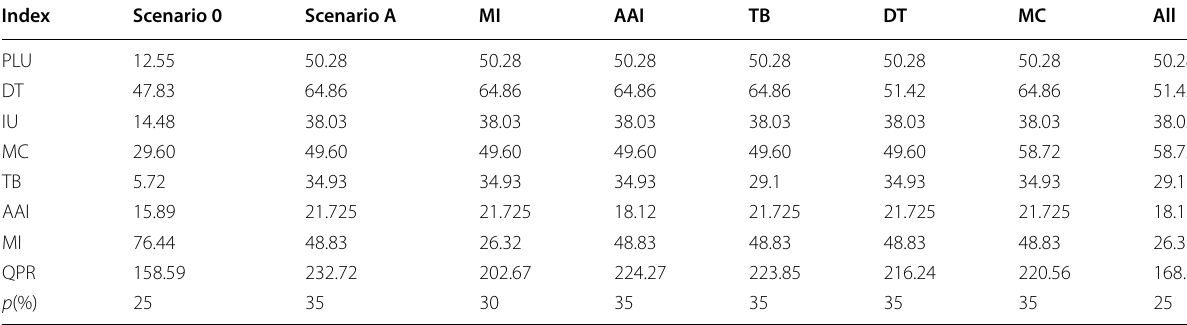
Table 3 Sensitivity analysis results on the penetration rate of